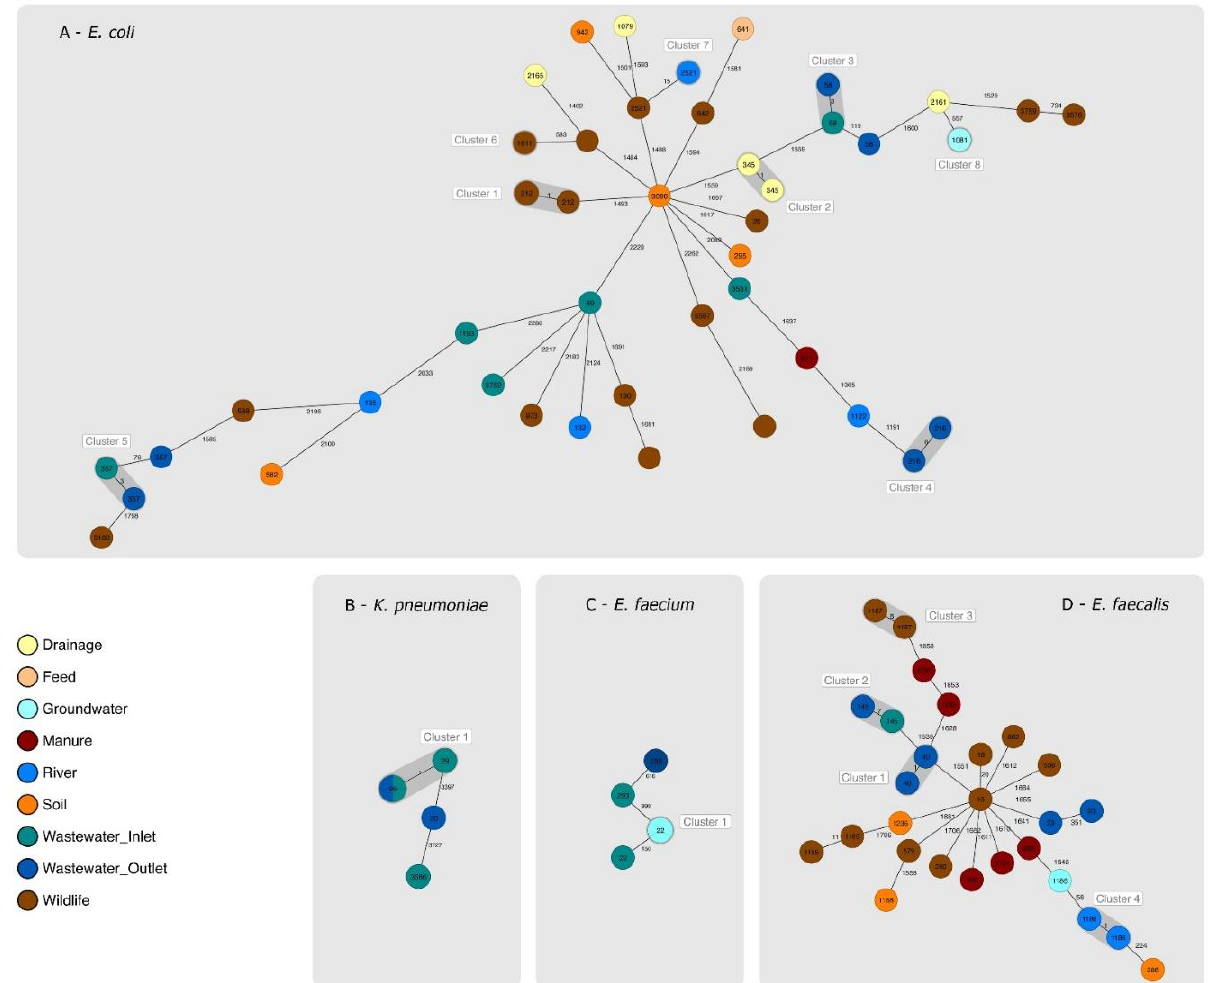
Figure 1. Genetic relatedness between isolates of the same species based on their core genomes. STs are indicated inside each circle, which represents one or more isolates. Empty circles correspond to isolates with new STs. Clusters are highlighted in grey. Colors identify the compartment from which each isolate was gained. The number of allelic differences between two or more isolates is shown on the connecting lines between them. ( A ) Minimum spanning tree (MST) displaying the collected E. coli isolates; ( B ) MST displaying the collected K. pneumoniae isolates; ( C ) MST displaying the collected E. faecium isolates; ( D ) MST displaying the collected E. faecalis